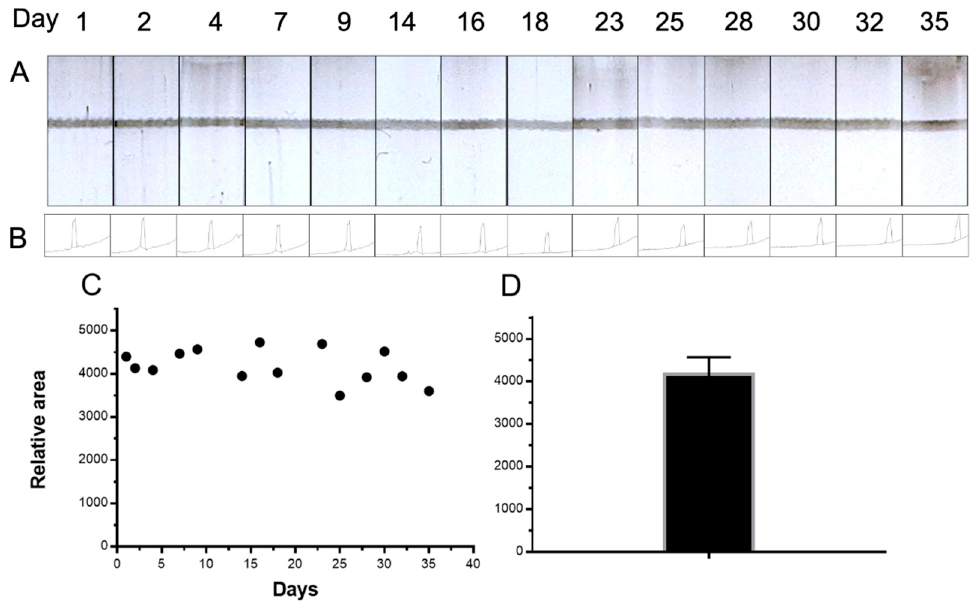
Figure 7. ( A ) The stability and repeatability study of the strips based on Av-CNP, performed with the control line for 35 days. The signal values for the relative areas are also shown in ( B ). ( C ) The plot of the signal intensities along with times of up to 35 days, while the mean value of the signal intensities’ areas is displayed in ( D ). The error bar shows the standard deviation for n = 14.